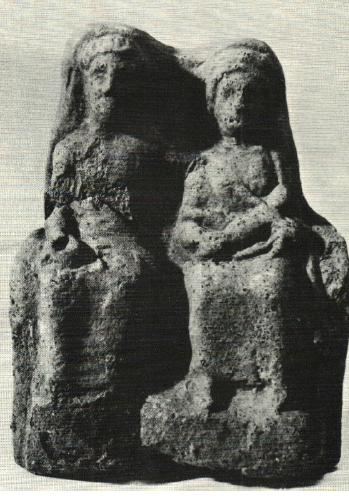
Figure 3. Gabii. From Almagro-Gorbea, “El santuario”, 271, n. 11, Tab. LI 2. 23 Almagro-Gorbea, “El santuario”, 271, n. 8 and 9, Tab. L 3, 4, inv. n. 65/57 and 65/2. With the same inv. n. (65/2), there is a similar but not at all identical statuette in Enea nel Lazio , A99. In n. 12, Tab. LI 3, the figure is more likely a dove, not a baby, according to a specific typology of this